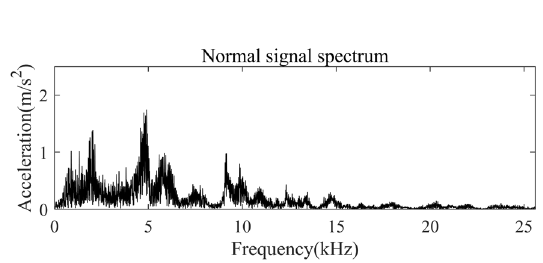
Figure 17 Normal signal spectrum